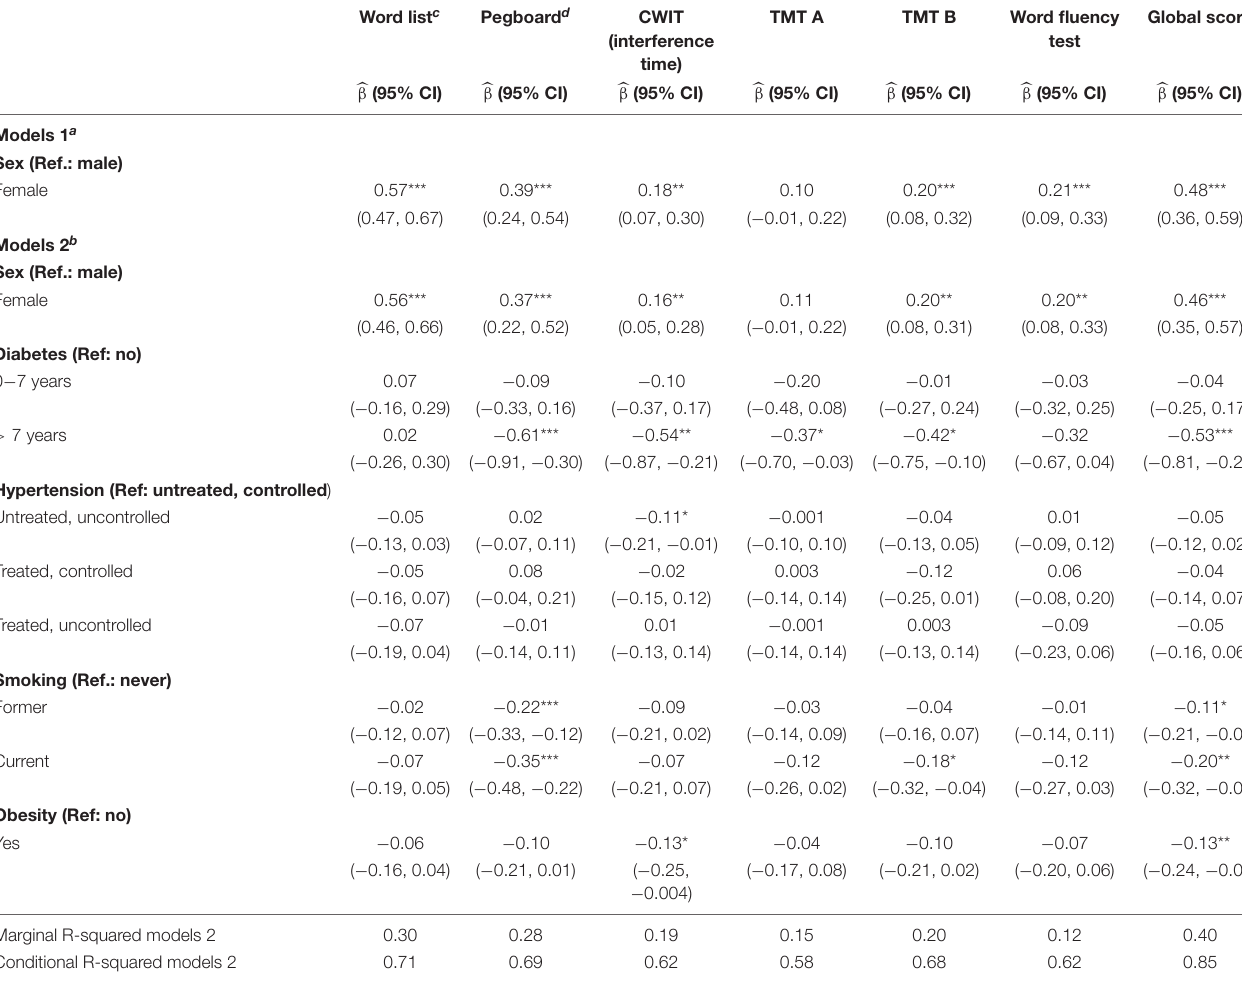
TABLE 2 | Association of sex with neuropsychological test results (z-scores) with and without adjustment for cardiovascular risk factors. Word list c Pegboard d CWIT